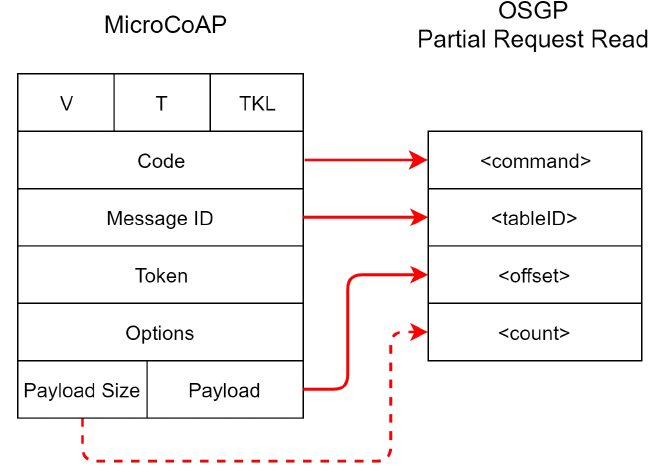
Figure 4. Mapping a request packet from CoAP to